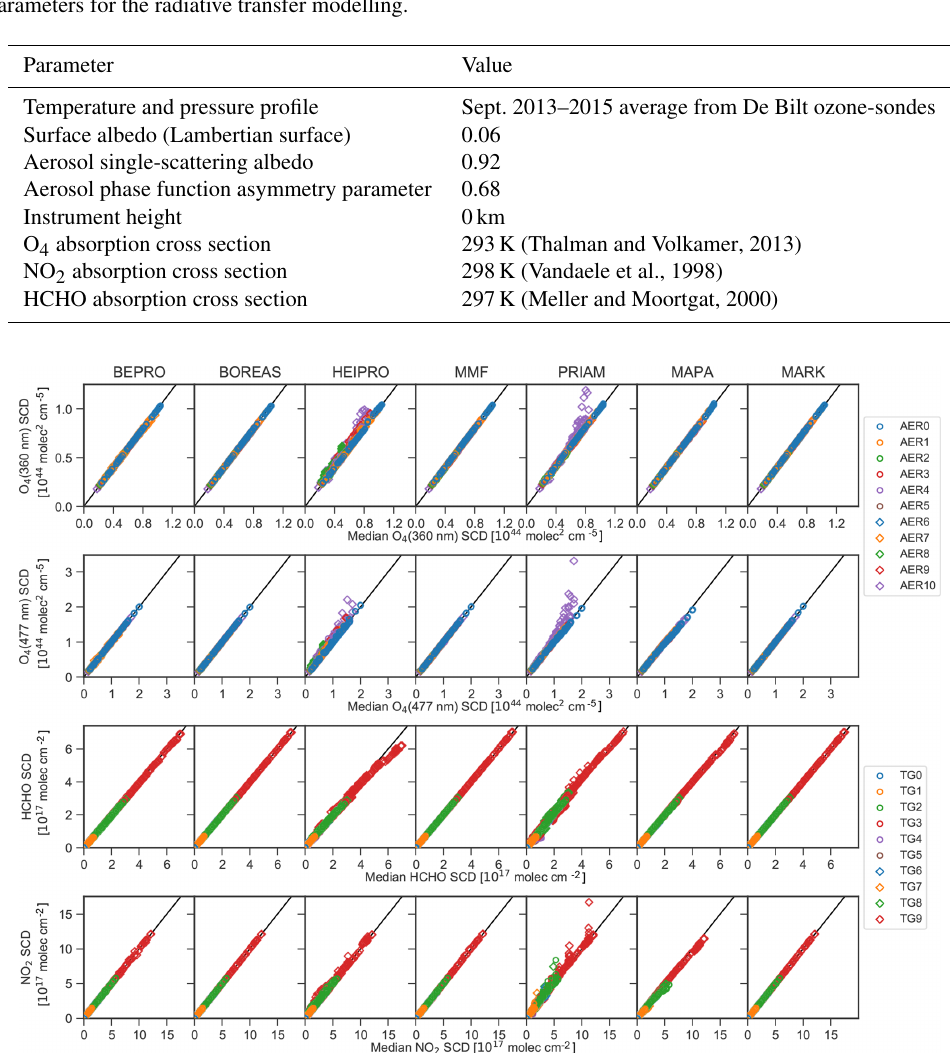
Figure 3. Correlation of SCDs of O 4 (360 and 477nm), HCHO, and NO 2 simulated by the different forward models with the corresponding median SCDs from all models. Colours indicate the underlying aerosol and trace gas profiles as denoted in the legend. For HCHO and NO 2 , results for all scenarios with different aerosol profiles are included.